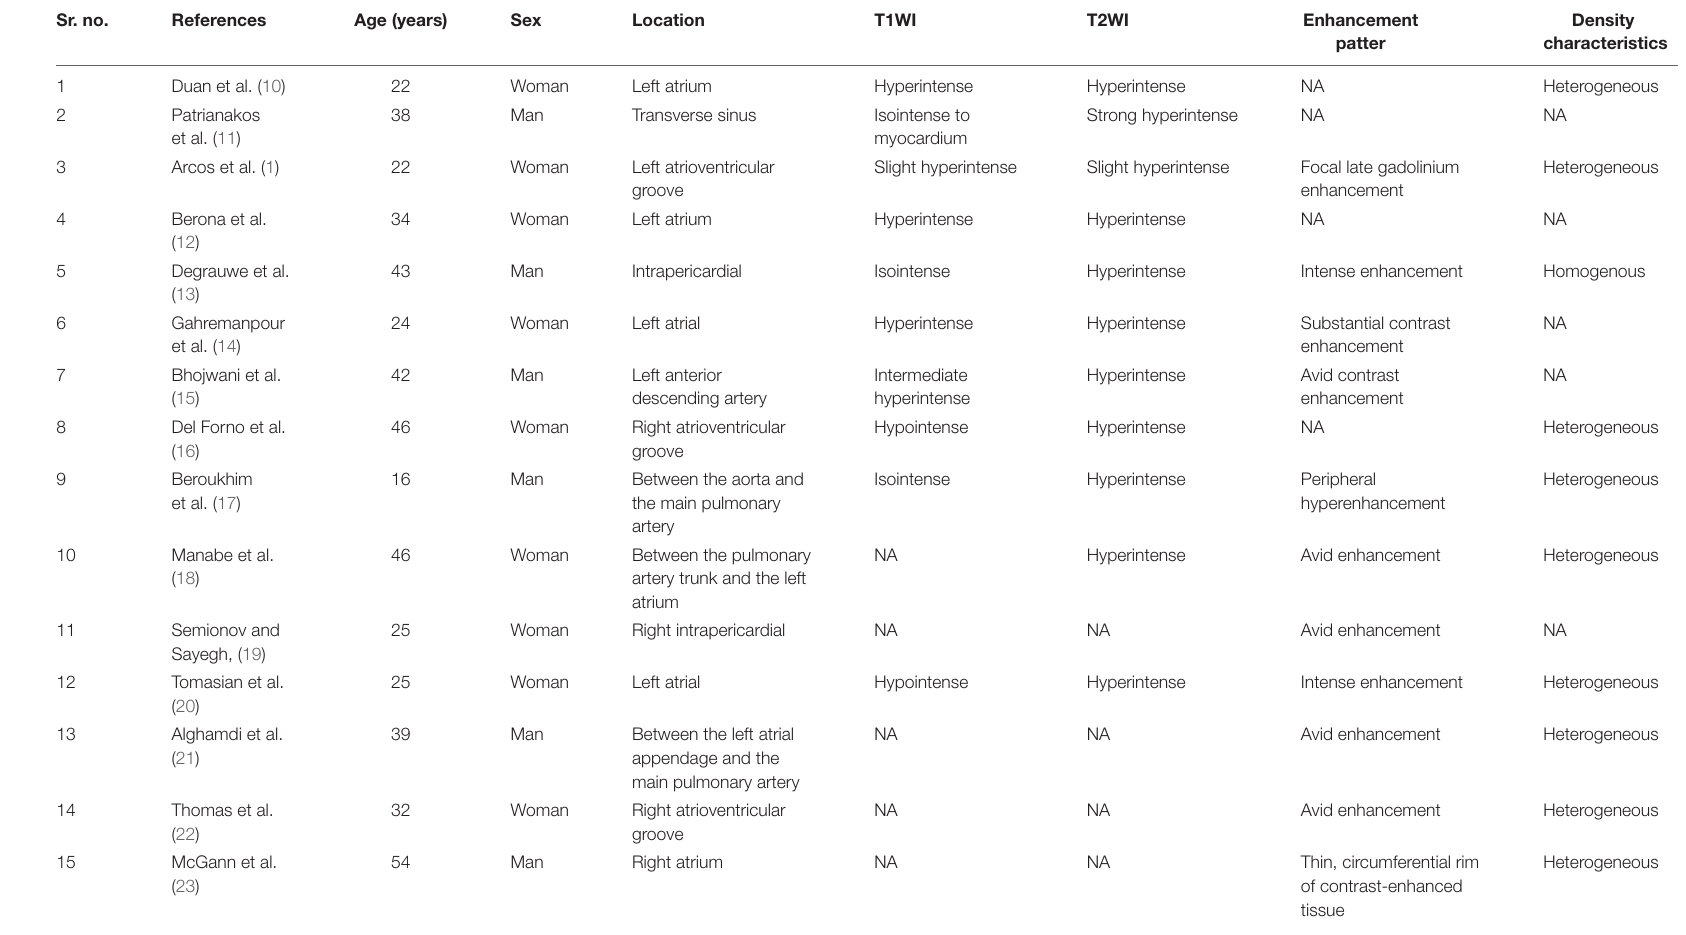
TABLE 2 | Magnetic resonance imaging findings of cardiac paraganglioma. Sr.